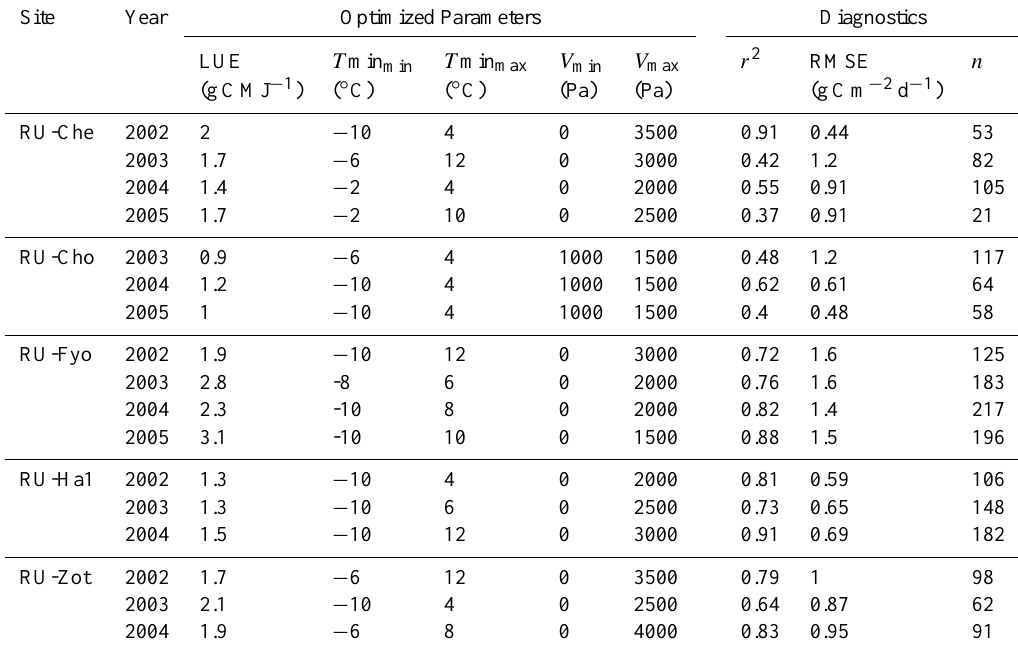
Table 3. Resulting optimized model parameters and regression diagnostics for the LUE model by site and year.